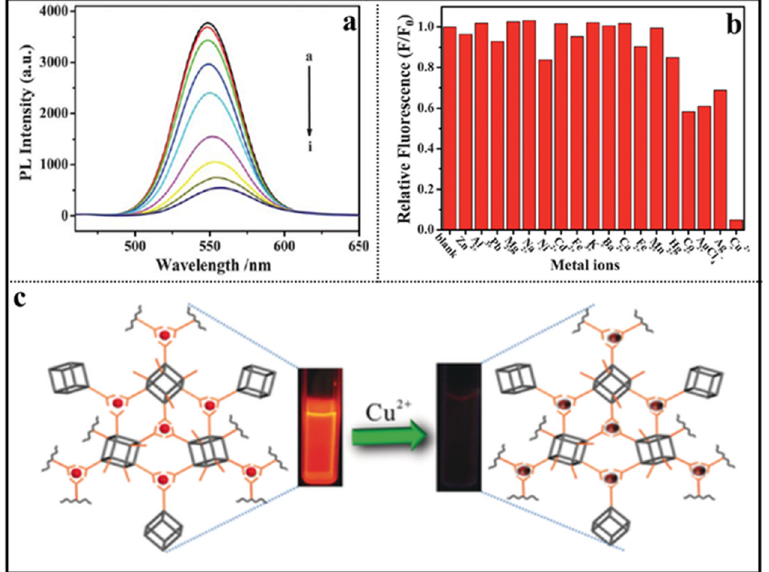
Figure 11. ( a ) Effect of Cu 2+ on the luminescence of the POSS-CdTe QDs at pH 7.4. The concentrations of Cu 2+ ( μ mol/L) in (a–i) are 0, 0.05, 0.1, 0.2, 0.4, 0.6, 0.8, 1 [65]. ( b ) Quenching effect of different ions on the fluorescence intensity of the POSS-CdTe QDs in a PBS buffer solution at pH 7.4 [65]. ( c ) Schematic diagram of the sensing process of POSS-Eu(dpa) 3 toward Cu 2+ [89].